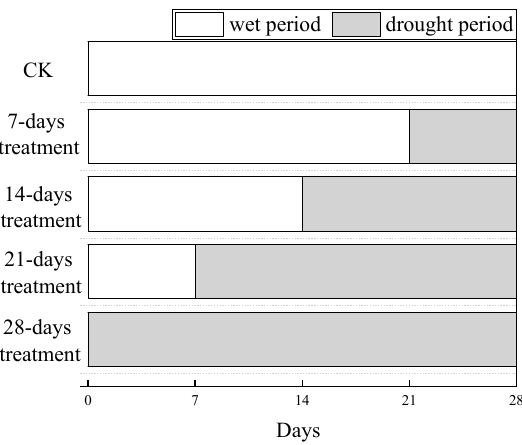
Figure 2. Drought periods in di ff erent treatments. CK: Control check.